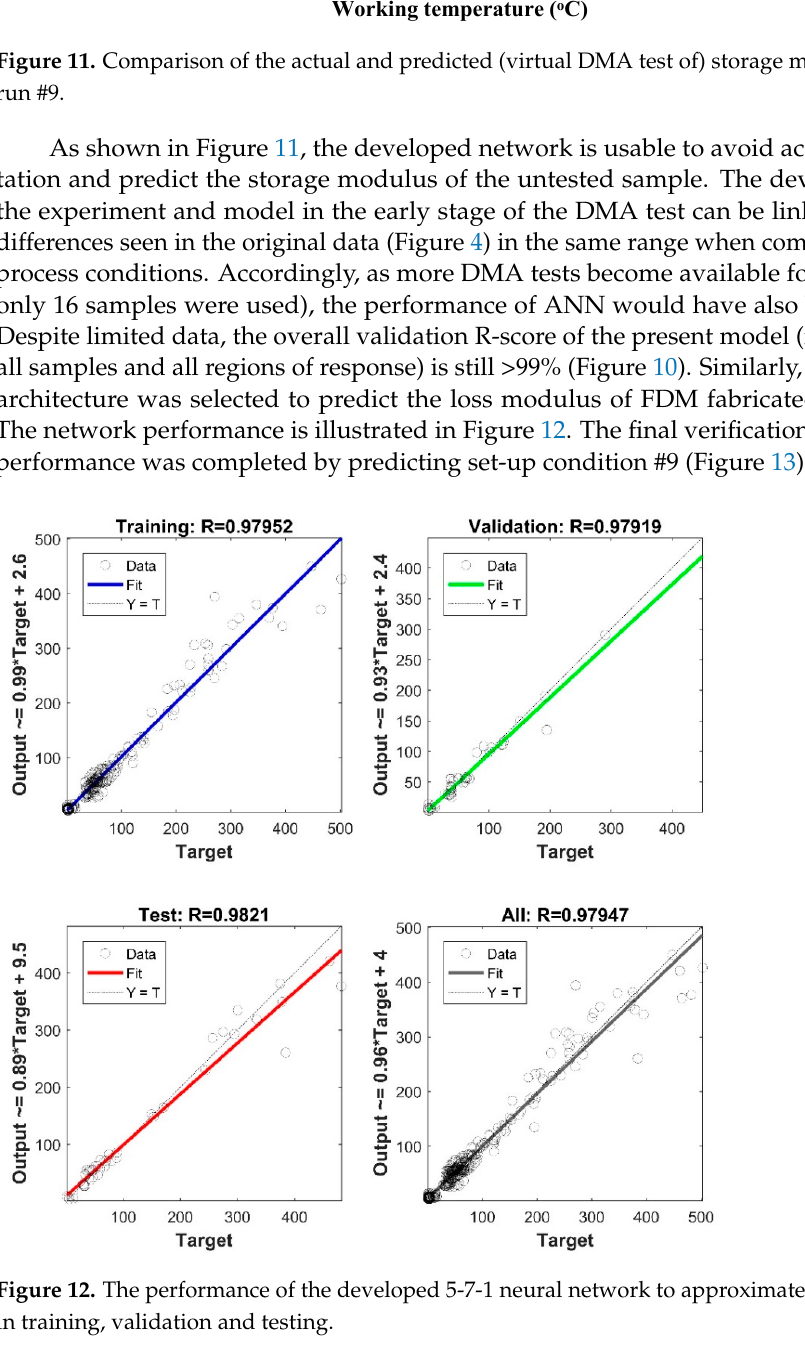
Figure 11. Comparison of the actual and predicted (virtual DMA test of) storage modulus, E ’, under run #9.